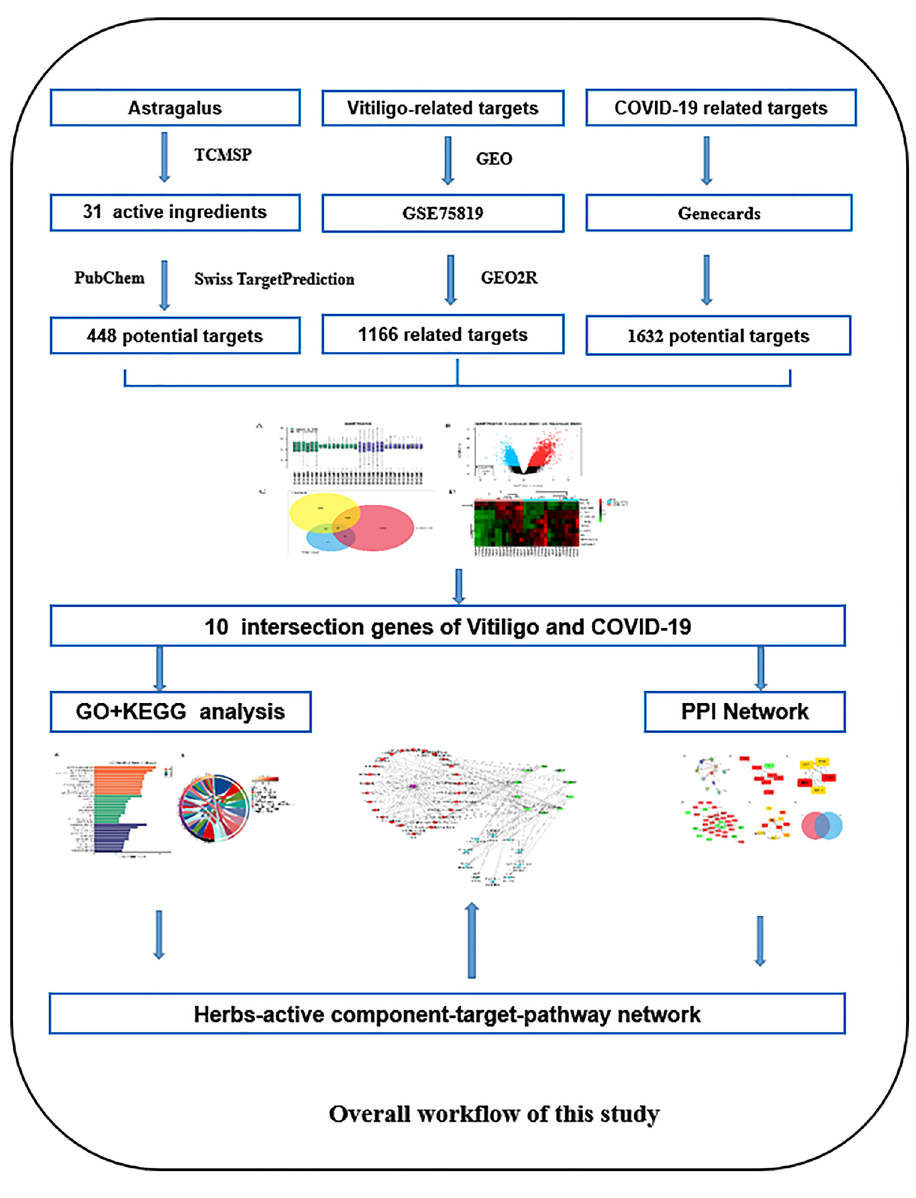
Figure 1. Overall workflow of this